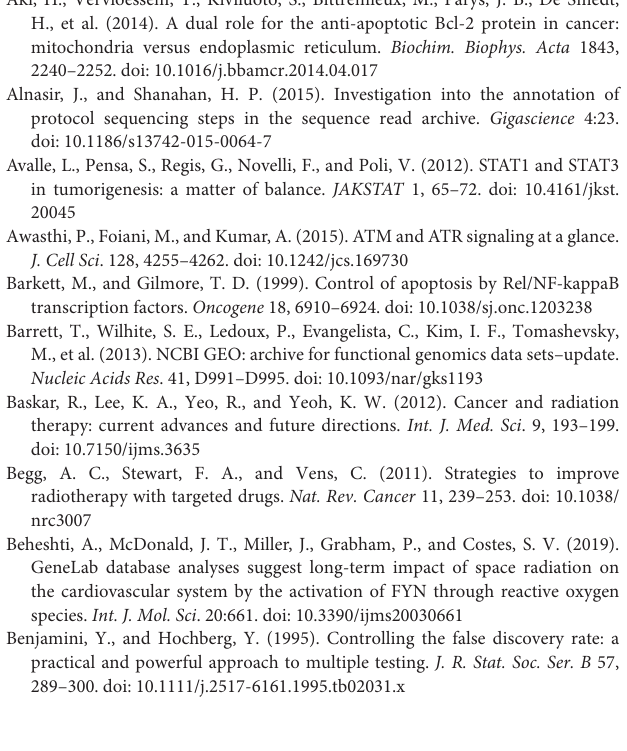
Supplementary Figure 1 | Schematic workflow outlining the selection of radiogenes. Venn diagram comparing the high-throughput (HTP) and literature-derived cancer radioresistance-associated genes. Functional enrichment and interaction network analysis of the common 88 genes resulted in 36 genes. Red, up-regulated genes; Green, down-regulated genes. Supplementary Figure 2 | Differential expression patterns of radiogenes in the corresponding cancer tissue; BRCA, breast invasive carcinoma; COAD, colon adenocarcinoma; LAML, acute myeloid leukemia. The red box represents cancer tissue samples and the gray box indicates normal samples. Supplementary Figure 3 | Kaplan-Meier curves depicting the prognostic value of radiogenes for overall survival in invasive breast carcinoma (A) CHEK1 , (B) PLK1 , (C) MAP2K1 and (D) NFKBIA . The HR “HR(high)” and the corresponding p-values “p(HR)” are shown. The 95% confidence intervals (CI) are denoted by dotted lines. The number of high-risk and low-risk patients are indicated by “n(high)” and “n(low),” respectively. Supplementary Table 1 | Samples from each transcriptomic dataset analyzed in this study. Supplementary Table 2 | List of the differentially expressed genes (DEGs) of each of the three transcriptome datasets and the DEGs common among